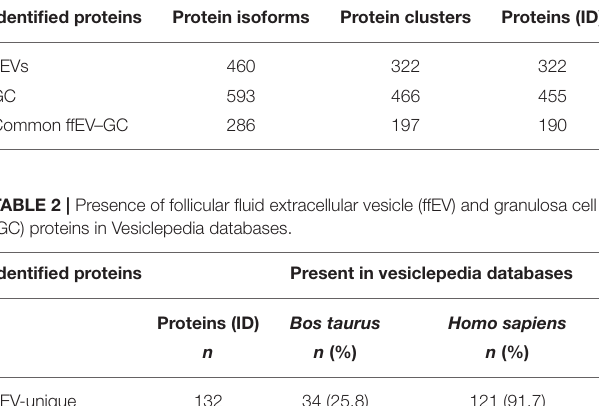
TABLE 1 | The number of proteins identified in bovine follicular fluid extracellular vesicles (ffEVs) and granulosa cells (GCs). Identified proteins